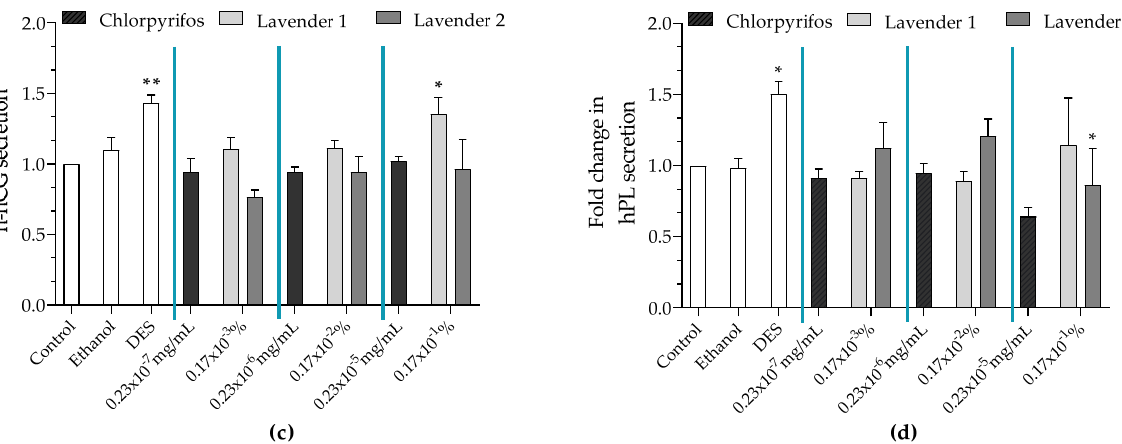
Figure 2. Quantification of the release of ( a ) progesterone, ( b ) estradiol, ( c ) h ‐ hCG and ( d ) hPL after incubation of JEG ‐ Tox cells with chlorpyrifos 0.23 × 10 − 7 mg/mL, 0.23 × 10 − 6 mg/mL and 0.23 × 10 − 5 mg/mL or two lavender EOs (1 and 2) at 0.17 × 10 − 3 %, 0.17 × 10 − 2 % and 0.17 × 10 − 1 % for 72 h. AP at